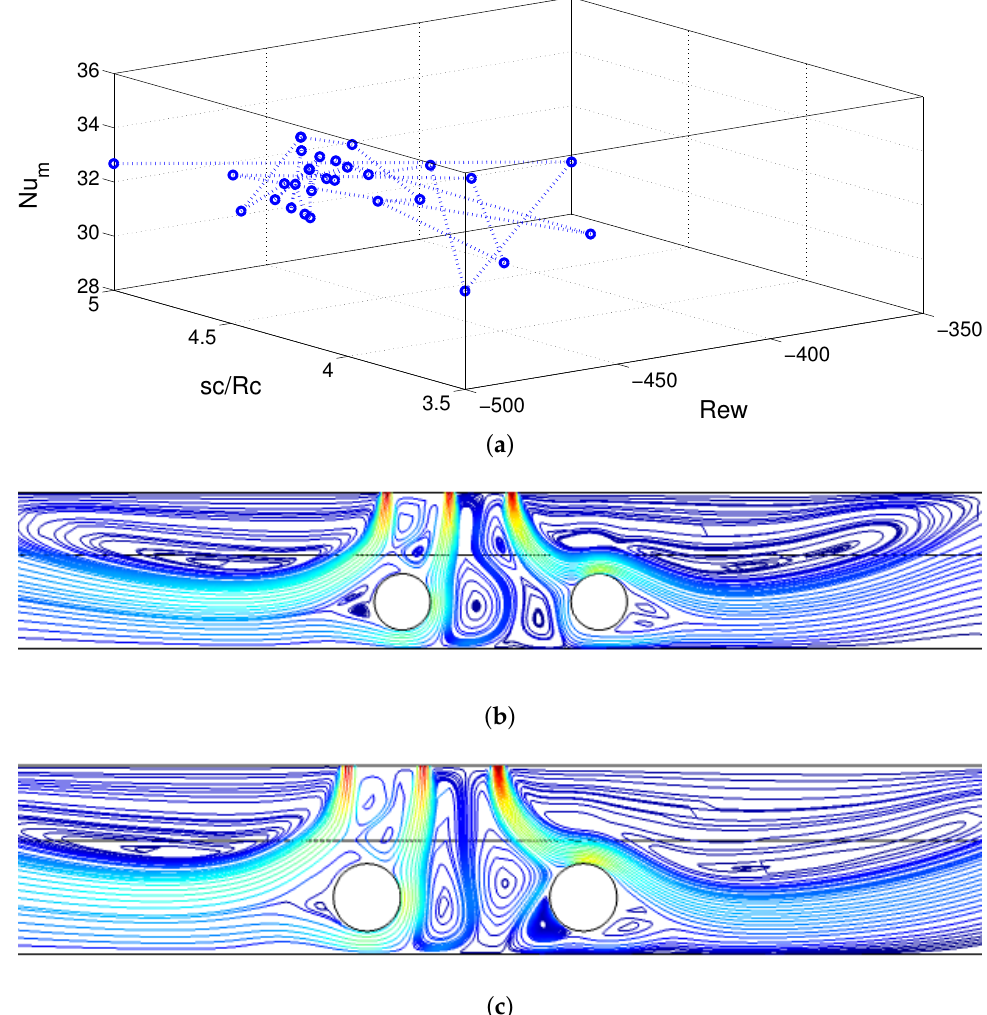
Figure 10. Search for the maximum value of objective function (average Nu from both cylinders C1 and C2) ( a ) and streamline variations at the best point of parametric CFD ( b ) and optimum point ( c ). ( a ) optimum search; ( b ) Rew = − 500, sc = 5Rc; Nu = 32.27; ( c ) optimum; Nu =